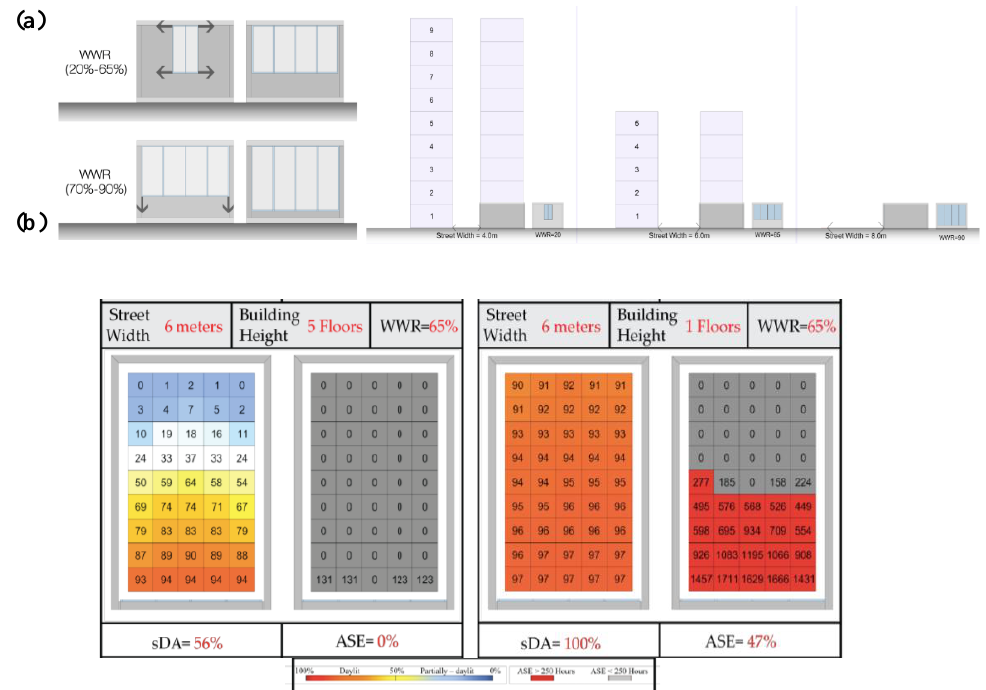
Figure 3.a. The different variables which are changed to provide different lighting results. Figure 3.b. The resulting lighting results for different factor settings. The South façade was examined, and a comparison was illustrated showing the difference between the daylight performance of one window ratio on the same street width but with different heights of opposite buildings. The tests revealed that the amount of sunlight exposure increases when decreasing the number opposite storeys and also the same happens with larger street